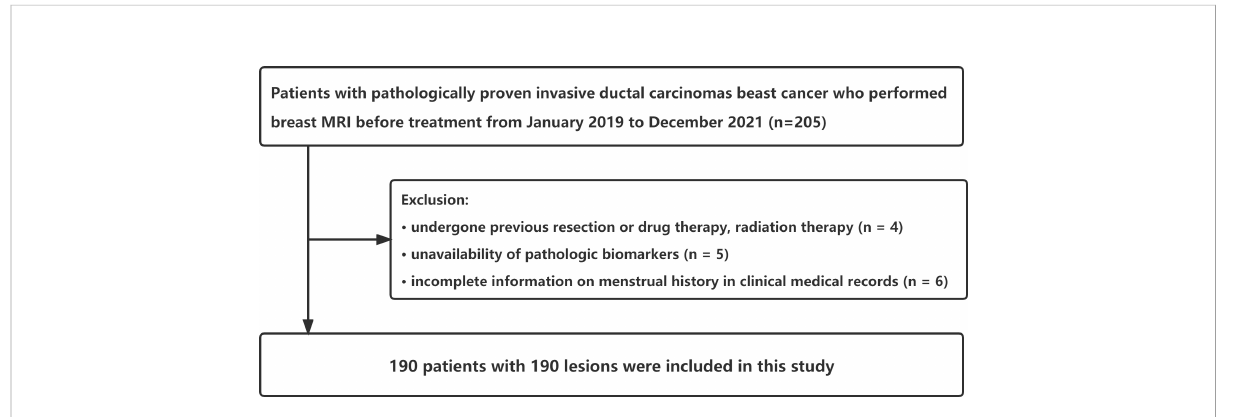
FIGURE 1 Flowchart of study population with exclusion